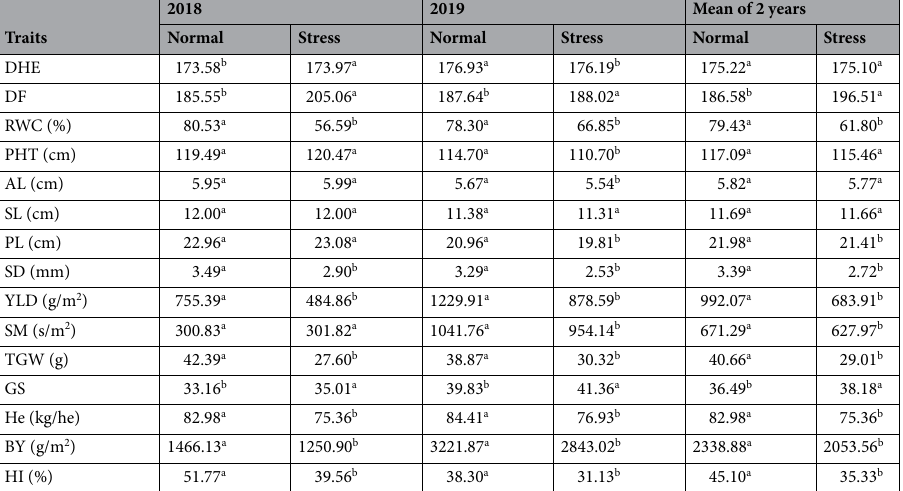
Table 1. Mean of agro-morphological and physiological traits evaluated under two irrigation levels (normal and stress) during 2018–2019 in synthetic hexaploid wheat derived lines. DHE, days to heading; DF, days to flowering; RWC (%), relative water content; PHT (cm), plant height; AL (cm), awn length; SL (cm), spike length; PL (cm), peduncle length; SD, stem diameter (mm); YLD (g/m 2 ), grain yield; SM, spike per m 2 ; TGW (g), thousand-grain weight; GS, grains per spike; He, hectoliter (kg/he); BY (g/m 2 ), biological yield; HI (%), harvest index. Means sharing no letter are significantly different at the 5% level by LSD